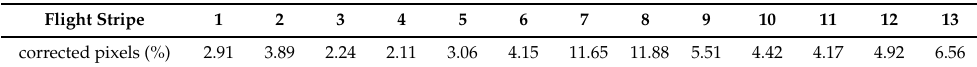
Table 2. Pixels changed by the WAF in percent (%) of all pixels Flight Stripe